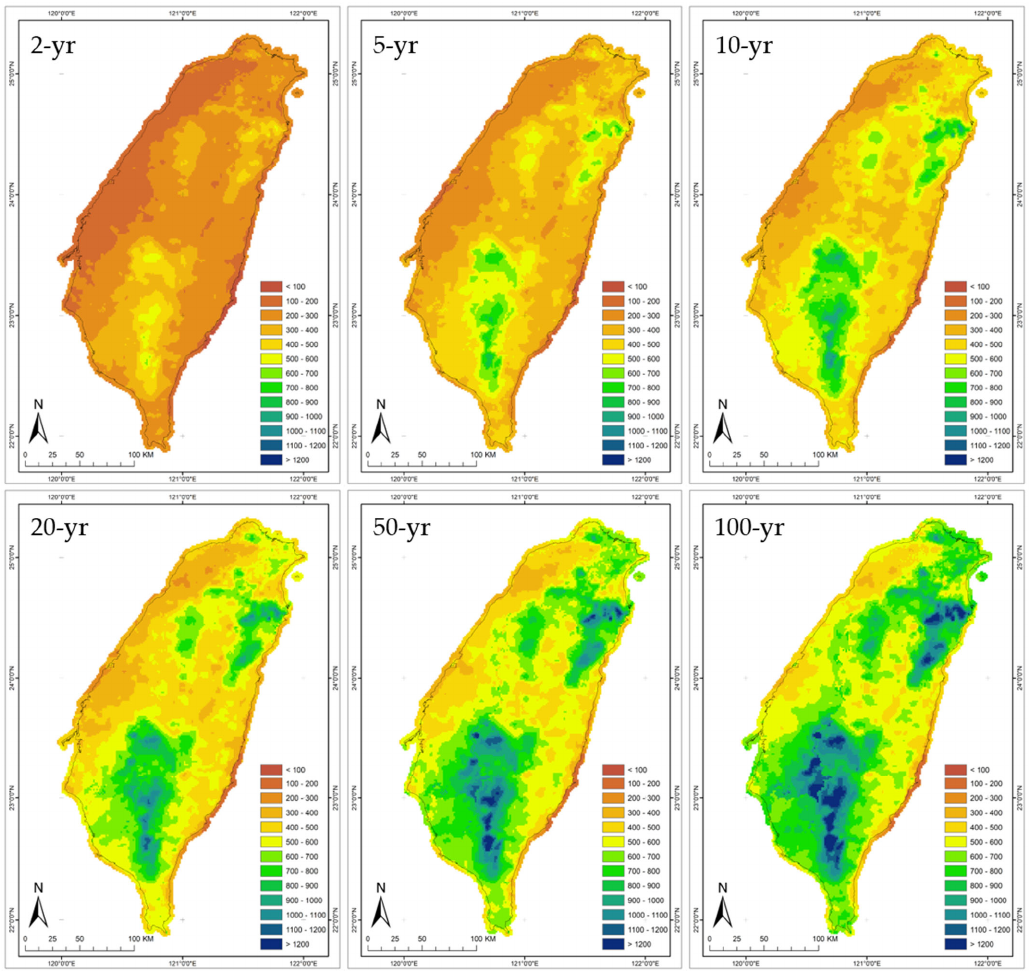
Figure 8. Spatial patterns of extreme rainfall for different return periods.